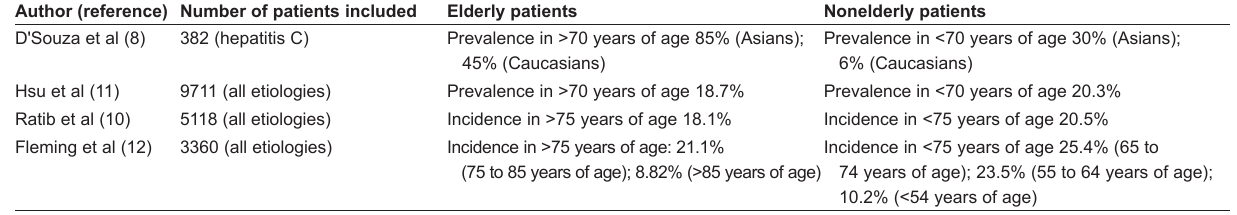
TABle 1 Prevalence/incidence of cirrhosis in elderly patients Author (reference) Number of patients included elderly